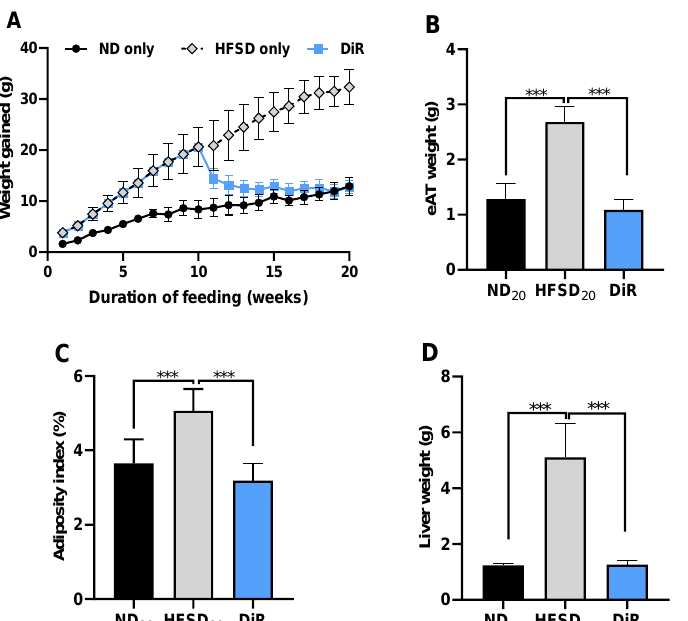
Figure 5. Diet reversal attenuates adiposity and liver weight gain. Mice were fed for a total of 20 weeks. ( A ) Cumulative weight change ( B ) Epididymal adipose tissue weight, ( C ) body adiposity index, and ( D ) liver weight in mice fed only the normal diet, only the high-fat/sucrose diet, and the diet reversal mice ( n ≥ 7 per group). Data expressed as mean ± S.D. ND 20 —20-week normal diet; HFSD 20 —20-week high fat diet; DiR—diet reversal; *** p ≤ 0.001. Mice fed on the normal diet and those fed only the high-fat/sucrose diet for 10 or 20 weeks did not differ in fasting blood glucose (Figure 6A). However, hyperinsulinemia (Figure 6B), insulin resistance (Figure 6C), and reduced insulin sensitivity (Figure 6D) pre- viously observed at 10 weeks in mice fed the high-fat/sucrose diet persisted at 20 weeks. Diet reversal reduced plasma insulin concentration and insulin resistance and increased insulin sensitivity to levels comparable to age-matched mice fed only the normal diet (Fig- ure 6B–D). Beta cell function did not differ between the three groups (Figure 6E).